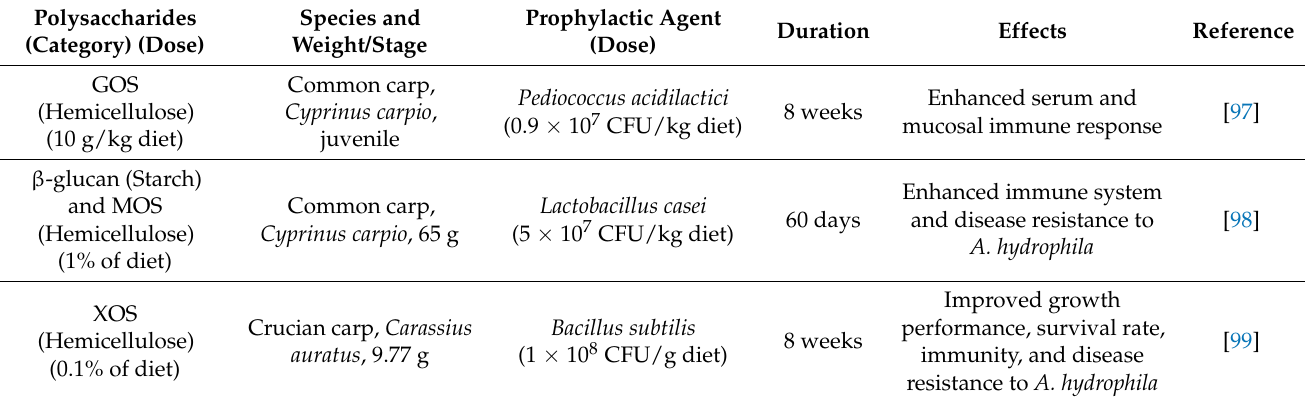
Table 4. Combination of polysaccharide and prophylactic agent to improve carp